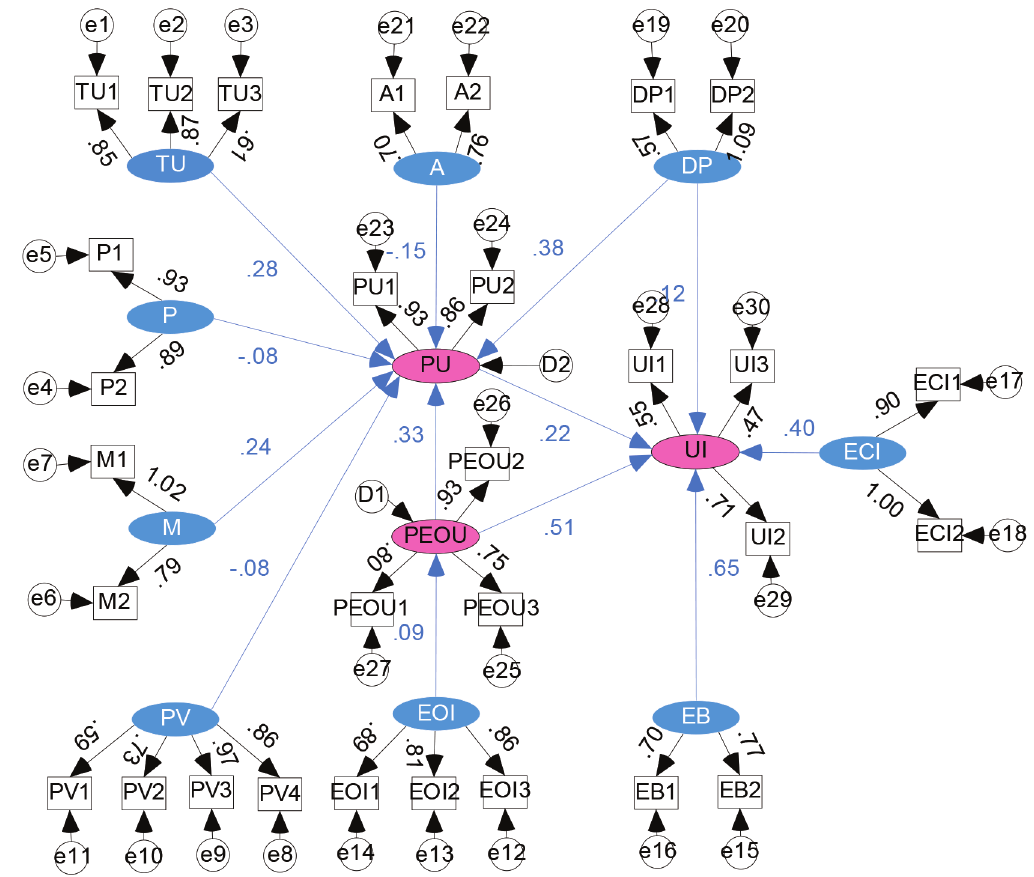
Figure 4. Path coefficients of